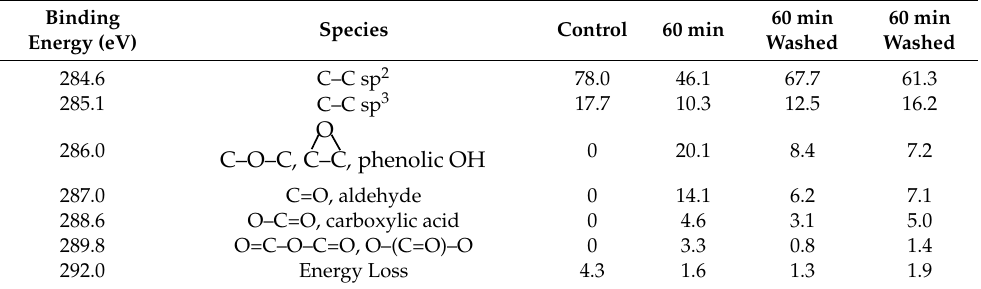
Table 2. Curve Fitting of C 1s Area Peaks for Untreated PS (Control), 60 min O atom Treated PS, and two 60 min O atom Treated PS Samples after Washed with Deionized Water. Binding energies and species were reproduced with permission from Taylor & Francis Ltd. www.tandfonline.com [4].